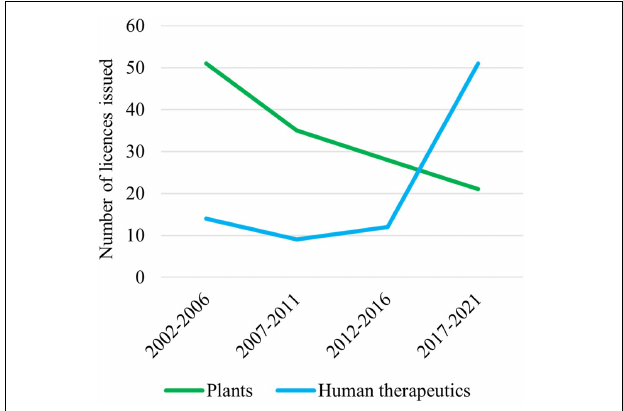
FIGURE 1 | Licenses issued by the Gene Technology Regulator (the Regulator) for plants and use of human therapeutics involving GMOs over the last 20 years. Note that these data do not include licenses issued by the Regulator for research on vaccines and therapeutics that are confined to